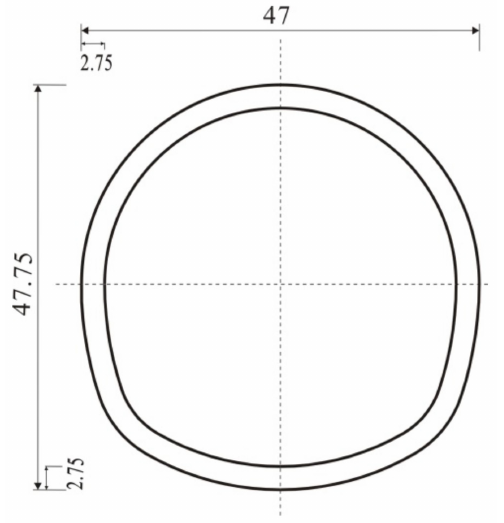
Figure 4. Section diagram of tunnel model (unit: